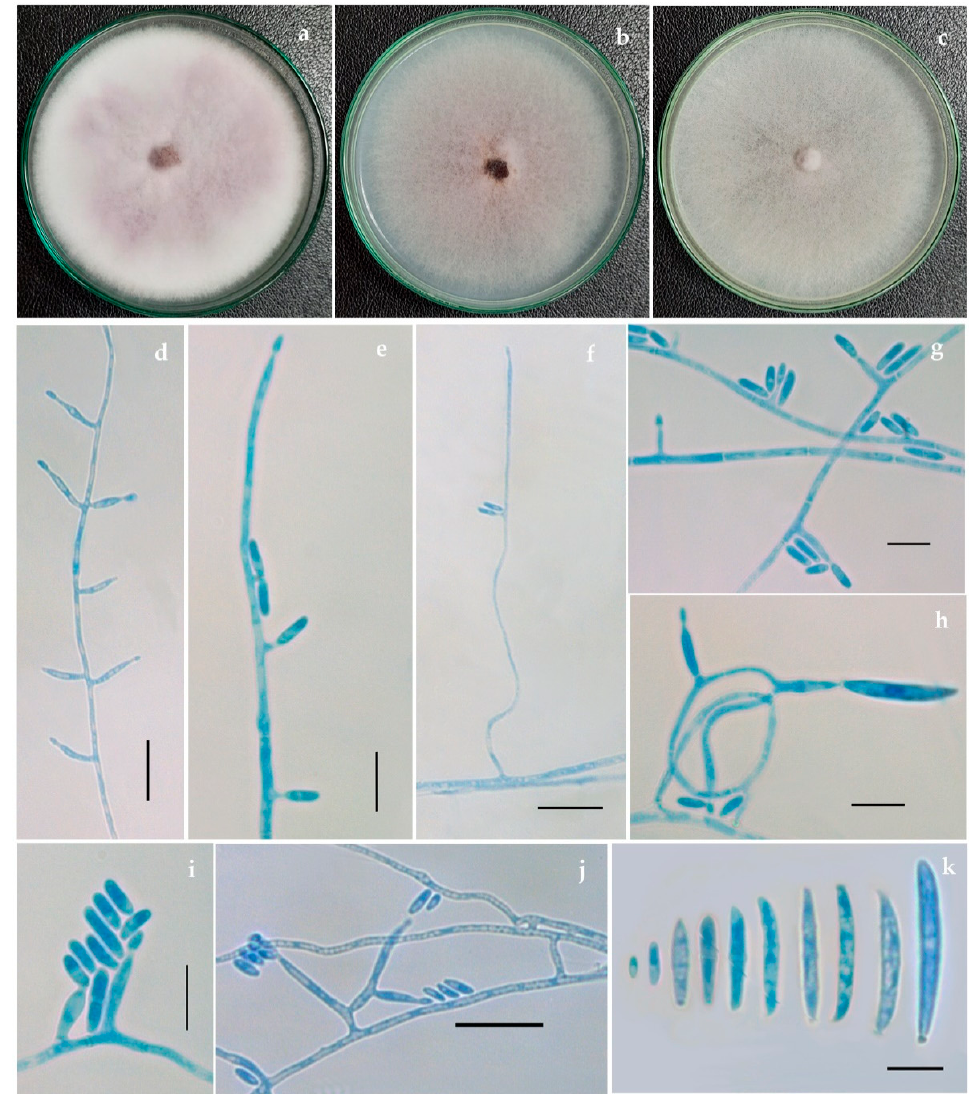
Figure 2. Fusarium tardicrescens (NFCCI 5201) culture grown on ( a ) Potato dextrose agar ( b ) Malt extract agar ( c ) Cornmeal agar ( d – j ) Phialides arising from mycelial hyphae producing micro and macroconidia. ( k ) Micro and macroconidia. Scale bars: d, f, j = 20 µm; e, g, h, i, k = 10 µm.